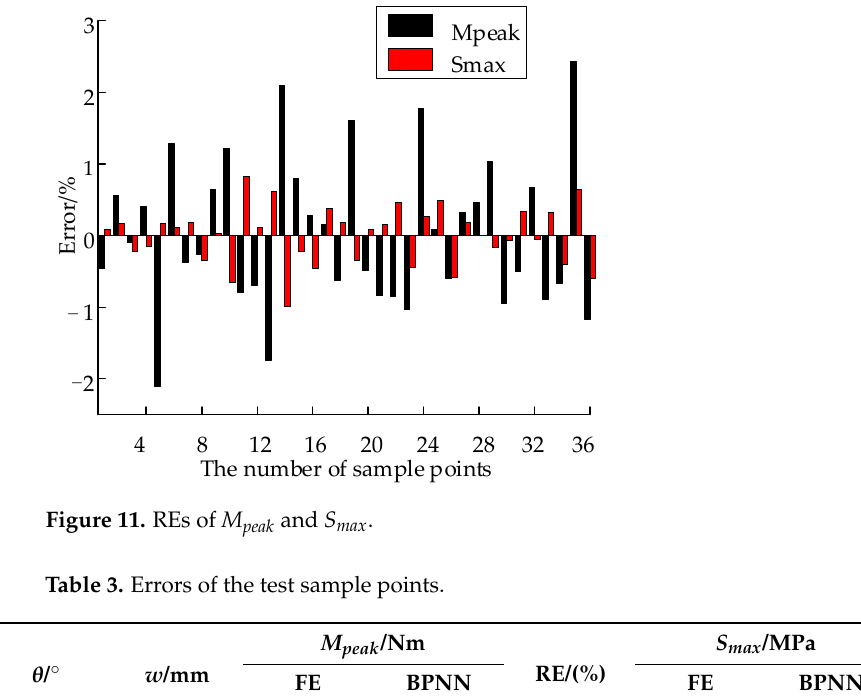
Figure 10. Fitting diagram of training sample points.